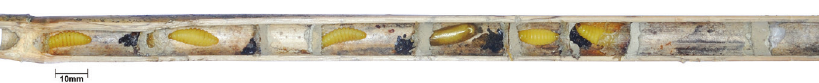
Figure 4. Trap SLT.025.A4 at opening.